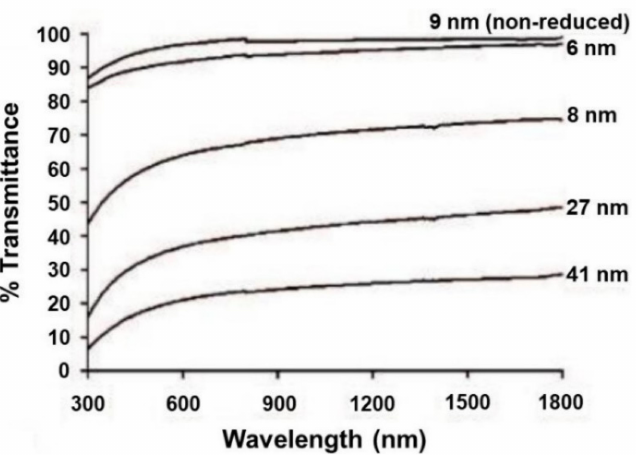
Figure 3. Optical transmittance spectra of the films with indicated thickness (Reproduced with permission from ref. [36]. Copyright 2008 American Chemical Society Publications).